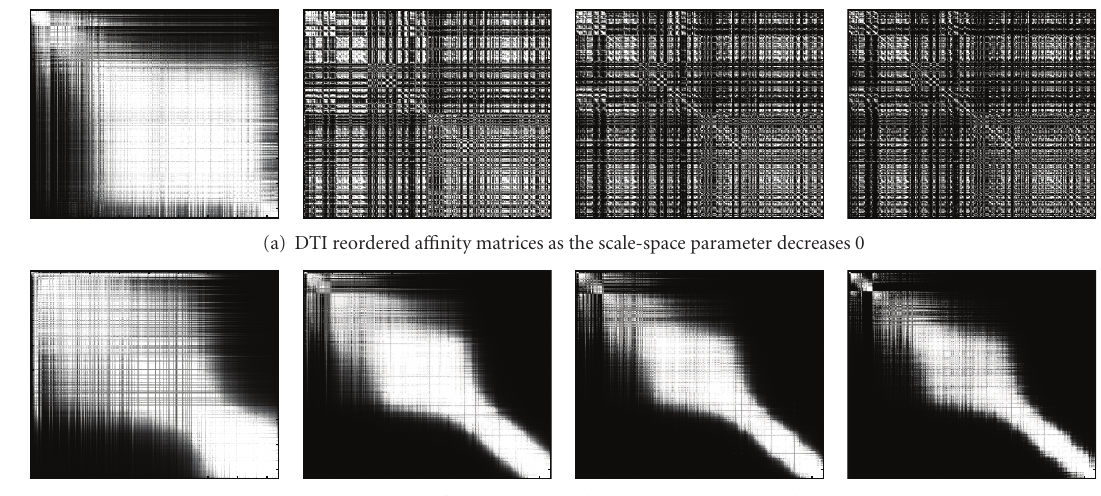
Figure 7: Plots of DTI and ODF a ffi nity matrices of an axial cropped slice shown in Figure 6. The matrices are reordered according to the second (Fiedler) eigenvector. ThePlots of DTI a ffi nity matrices are shown in decreasing order of σ , which takes the values 1 / 5, 1 / 10, 1 / 20, and 1 / 40 of the quantity of elements to cluster. In the DTI case, the decreasing on the scale parameter σ leads to a matrix with highly correlated elements that is very di ffi cult to cluster. In the ODF case, the block structure is clear and is better suited to apply a clustering algorithm.